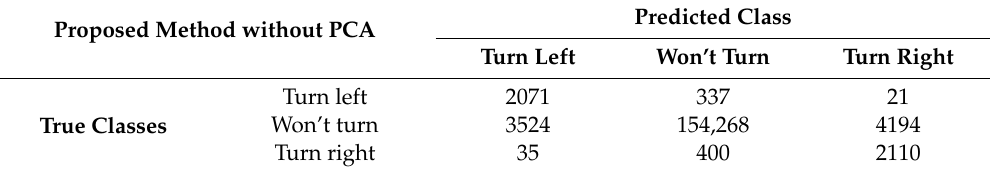
Table 10. The confusion matrix of the proposed method without PCA with 0.1 s prediction time.